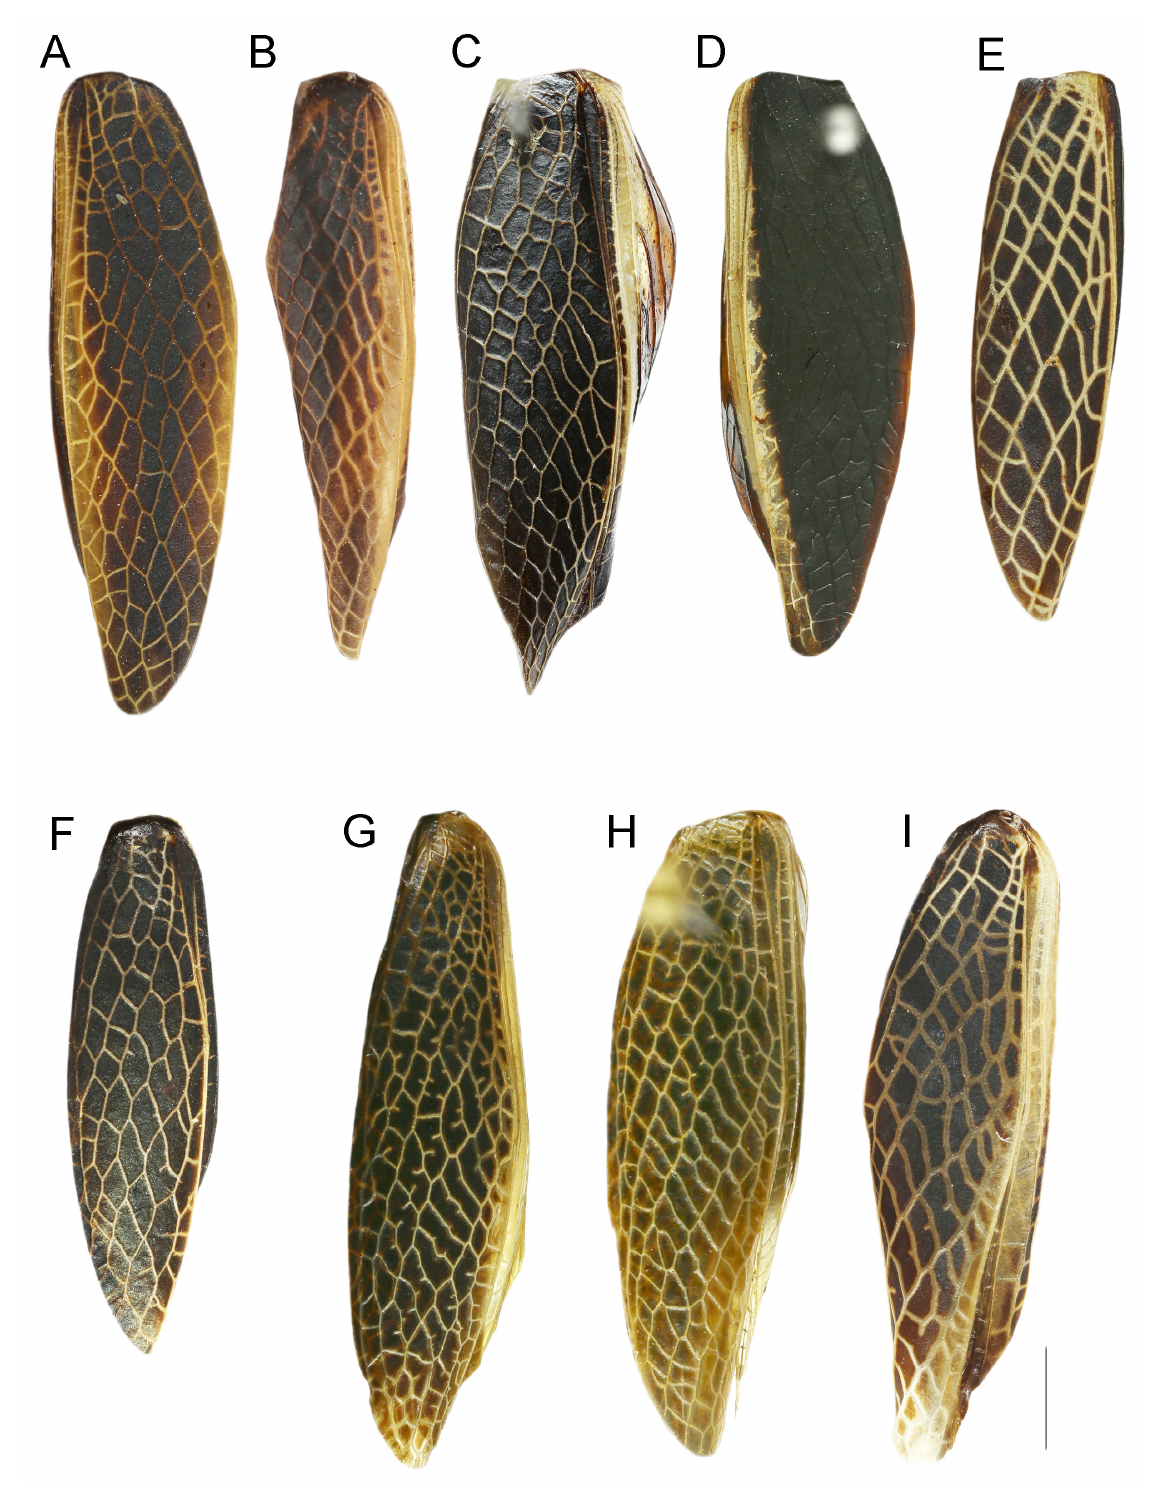
Fig. 14. Female tegmina in dorsal view. A . Nisitrus brunnerianus Saussure, 1878. B . N.